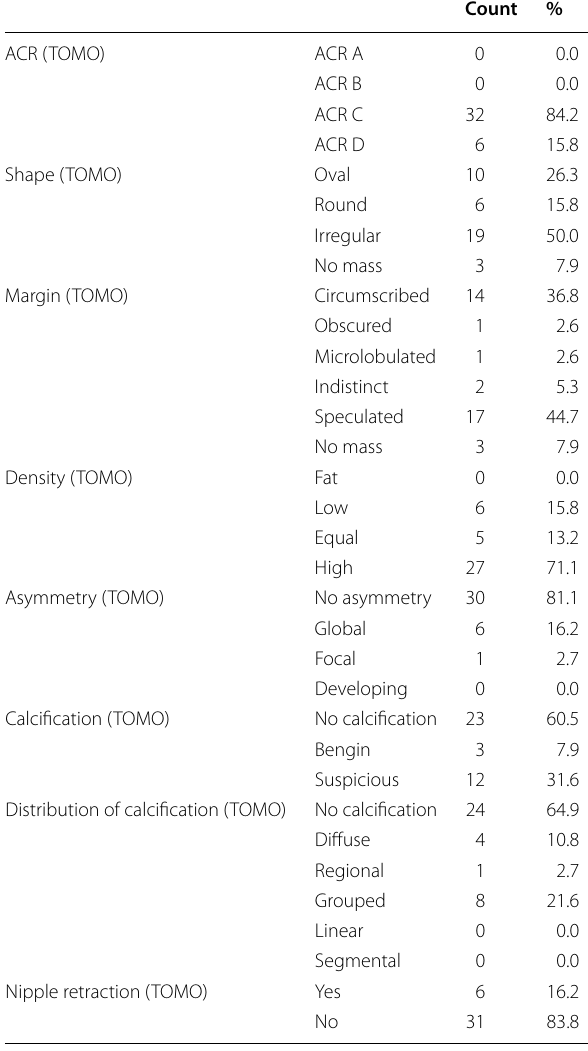
Table 3 Characterizations of lesions in